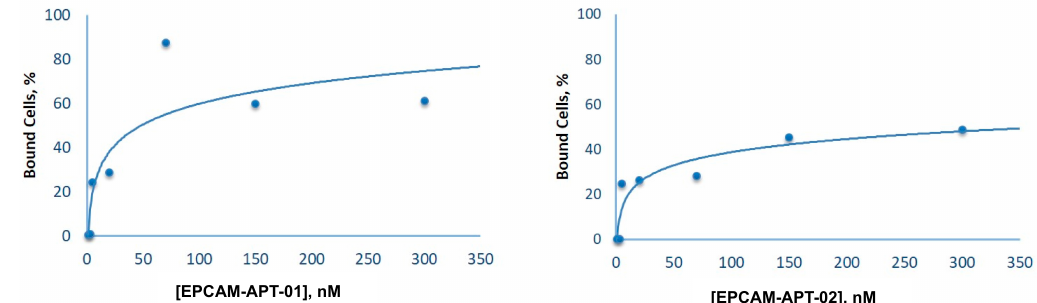
Figure 4. Aptamer affinity curves. The percentage of bound LC cells measured by flow cytometry versus concentrations of EPCAM-APT-01 or EPCAM-APT-02.